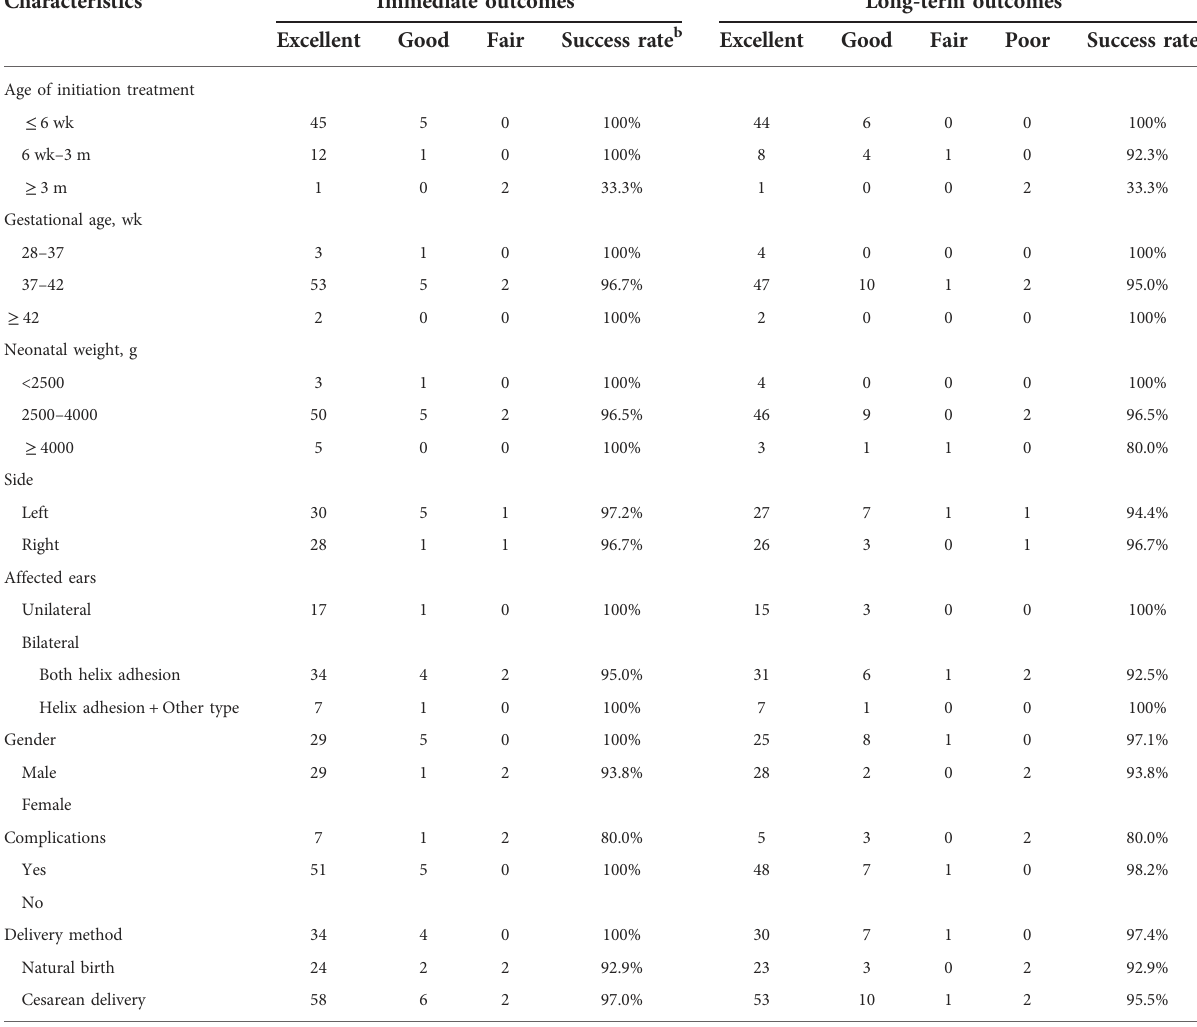
TABLE 2 Immediate and long-term outcomes of the 66 ears with helix adhesion.